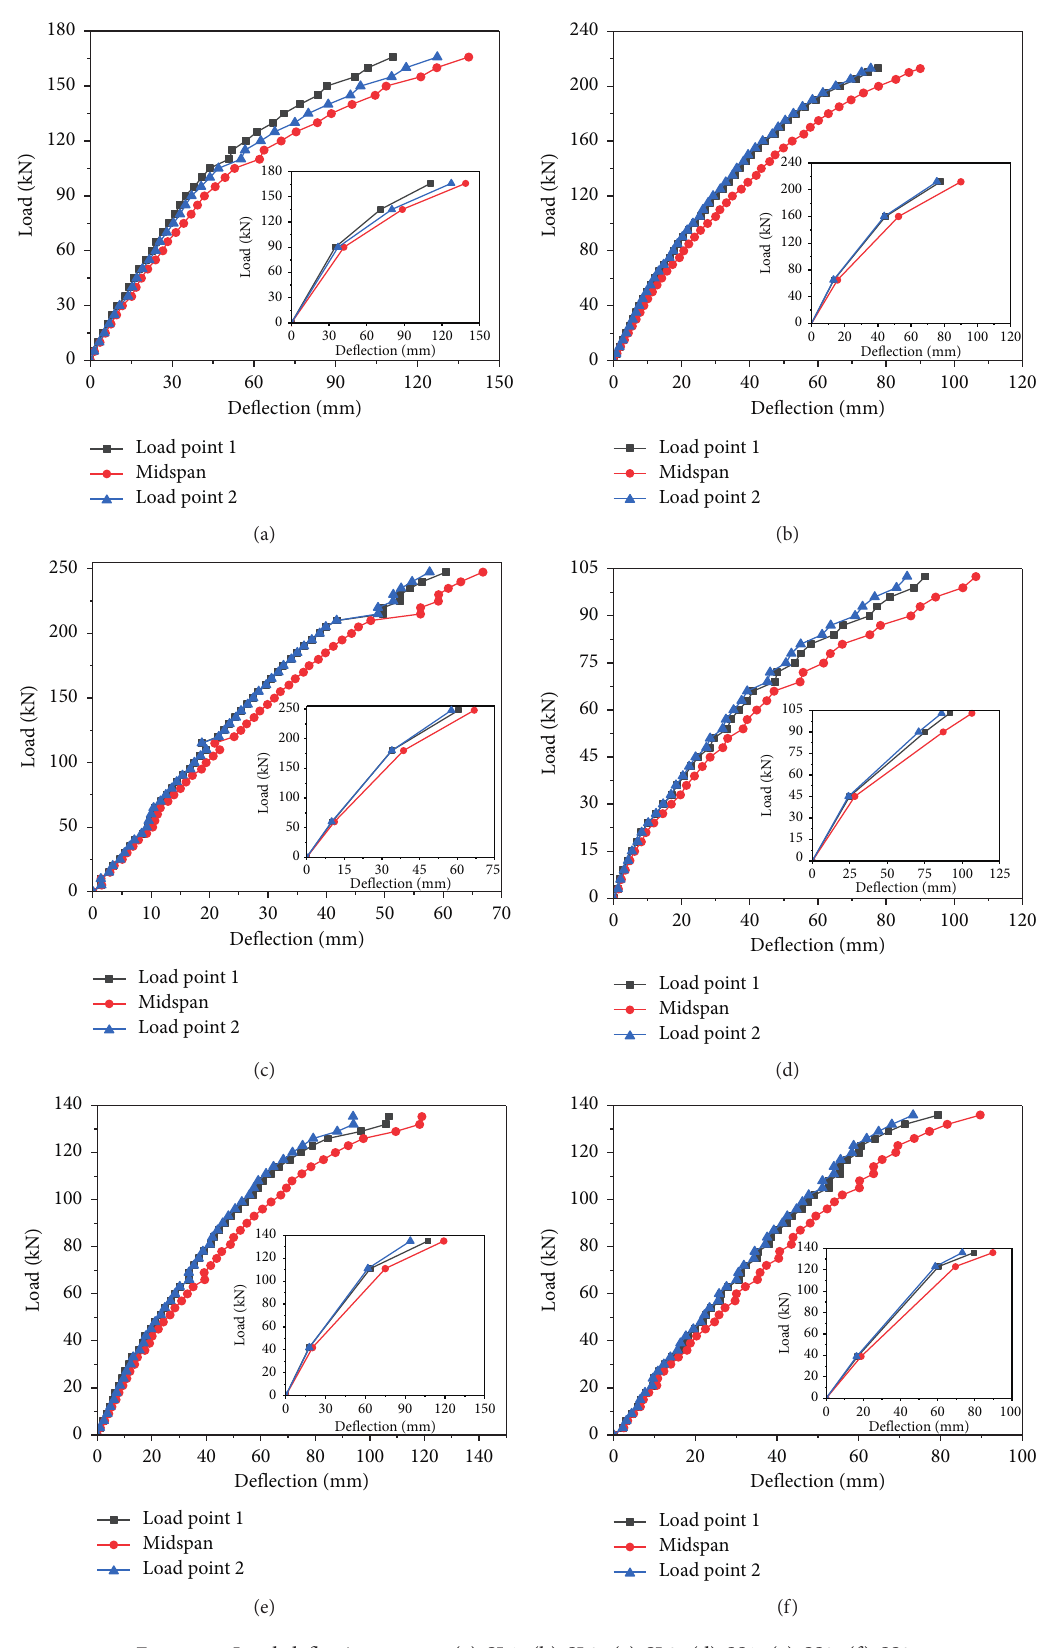
Figure 5: Load-deflection curves: (a) SL1; (b) SL2; (c) SL3; (d) SS1; (e) SS2; (f)